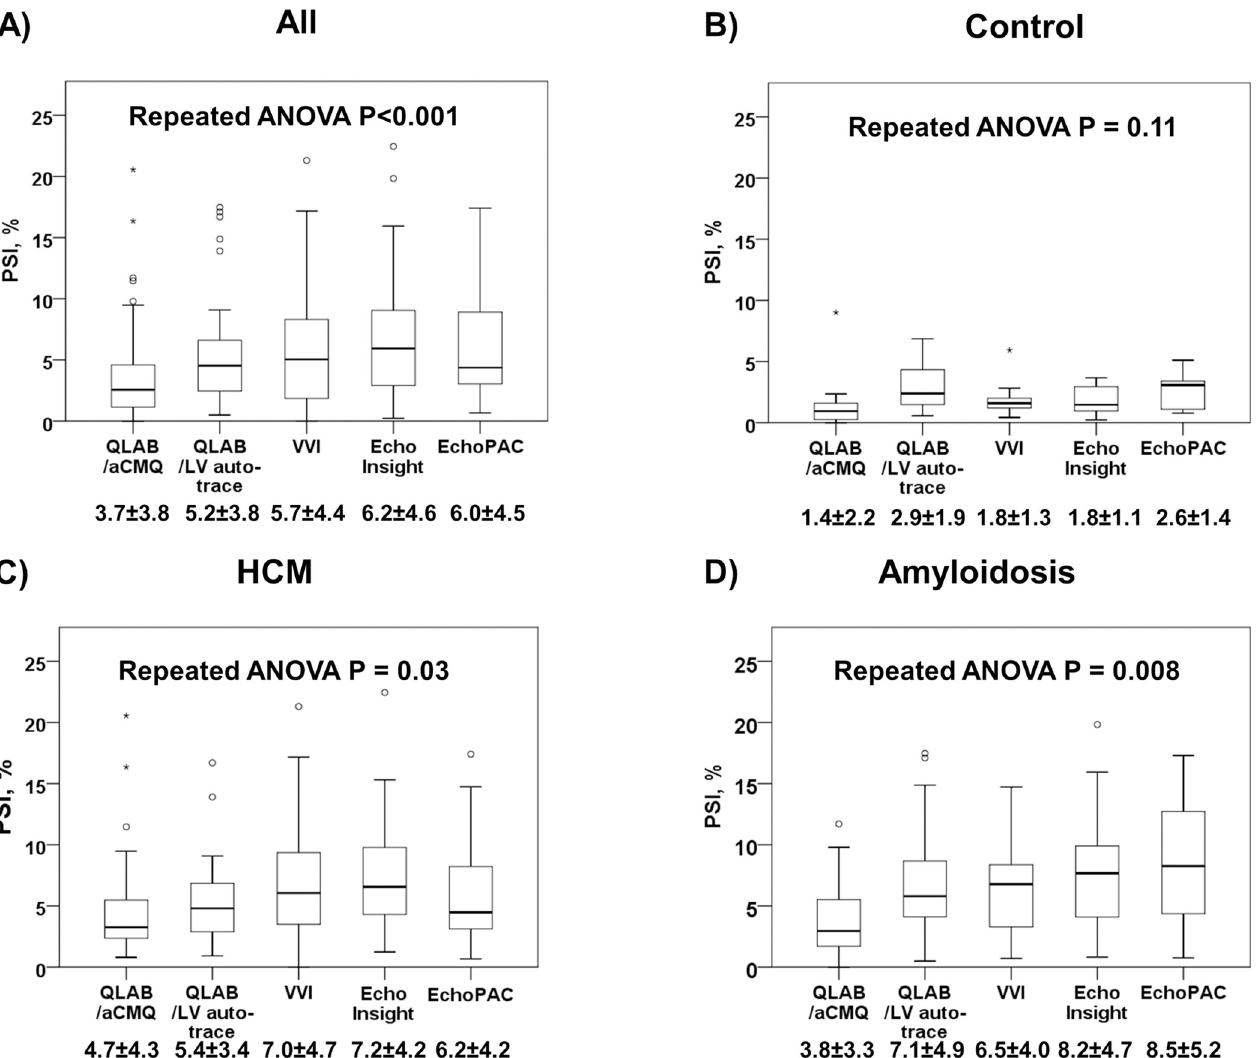
Fig 4. Post-systolic shortening index (PSI) by strain software in (a) all patients, (b) healthy controls, (c) hypertrophic cardiomyopathy (HCM), and (d) cardiac amyloidosis.